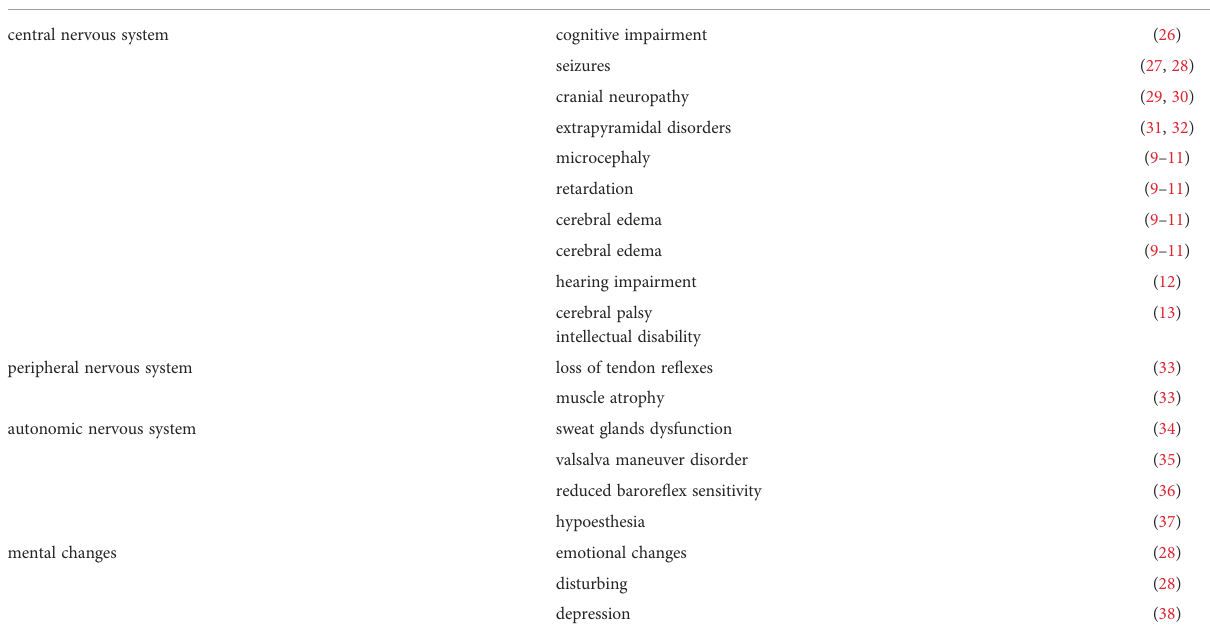
TABLE 1 The symptoms of uremic